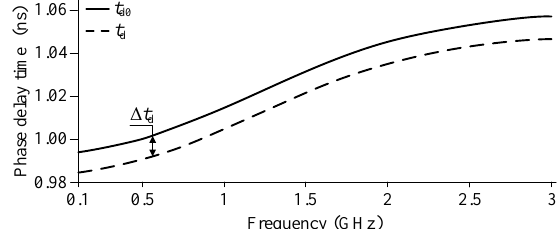
Fig. 4. Change in phase delay time when the length of a meander conductor is changed by one percent. The calculation of the impact coefficients of the constructive parameters of meander slow-wave systems with additional shields grounded at both edges is provided in the next